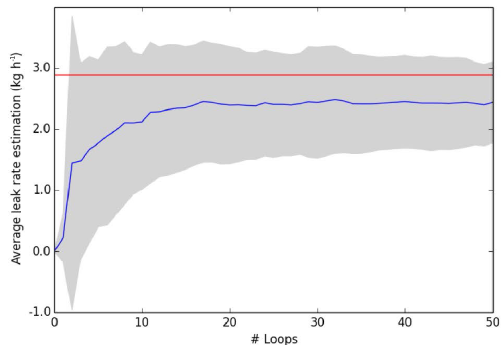
Figure 6. Rate of convergence toward the final leak rate estima- tion as a function of the number of loops for LES CASE UCD508. By 15 laps, the emissions estimate (blue line) has stabilized to 2.5kgh − 1 compared to the actual leak rate (red line) of 2.9kgh − 1 . Dimensionless distance R = 0.25, 50 realizations. Gray area repre- sents 1 SD (standard